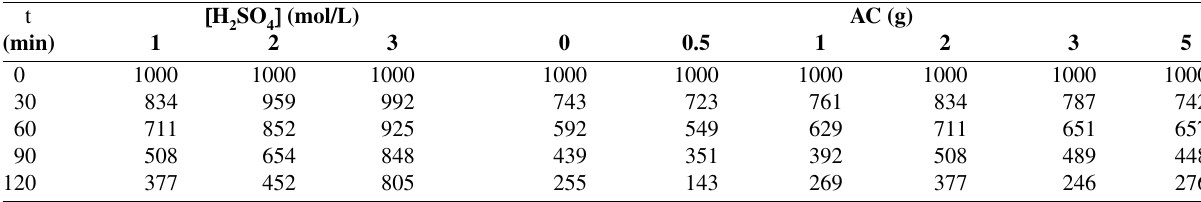
Table 2. Manganese concentration (mg/L, in italics) remaining in solution, with respect to initial sulfuric-acid concentration (mol/L), quantity of activated carbon (g) and reaction time (min). t